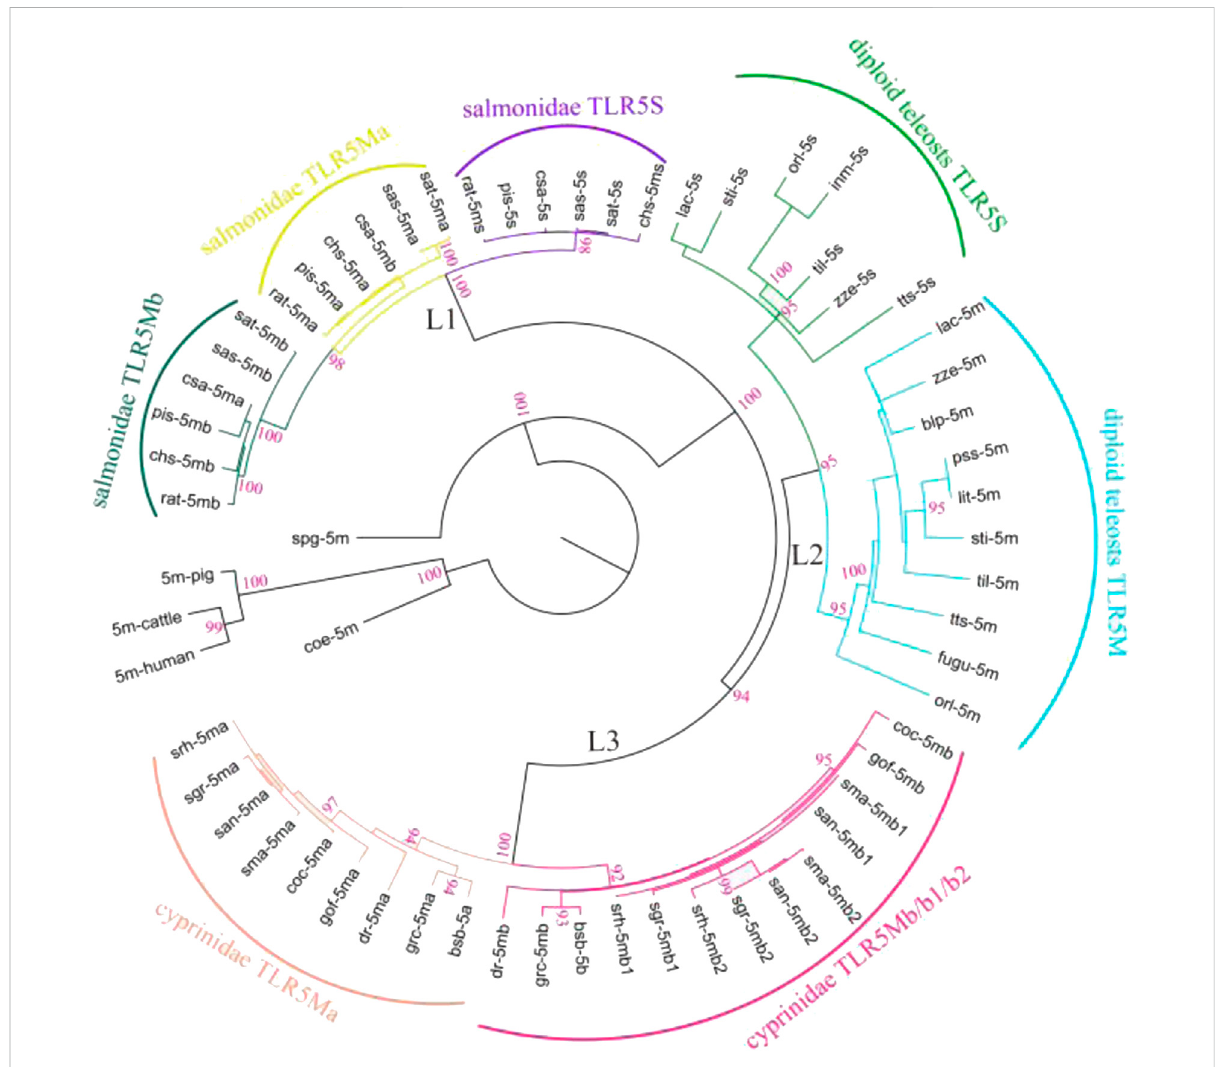
FIGURE 1 Phylogenetic relationships among various fi sh TLR5s . Representative TLR5 genes were categorized into three main clades (L1, L2, and L3). Furthermore, diploid teleost TLR5 genes were classi fi ed into two subgroups (diploid teleost TLR5S and TLR5M). TLR5 genes in Salmonidae were clustered into three different clades (salmonidae TLR5S, TLR5Mb, and TLR5Mb). TLR5 genes in Cyprinidae were divided into two subgroups (cyprinidae TLR5Ma and TLR5Mb/b1/b2). Detailed abbreviation of each species is available in Table